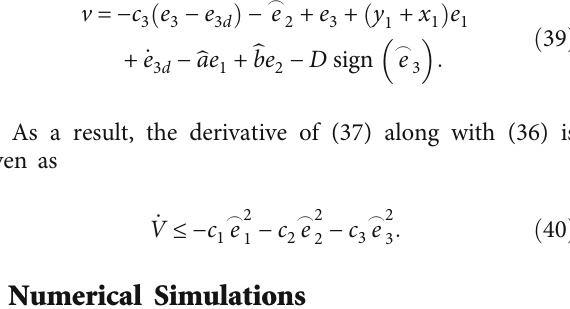
Figure 2: Control signal.